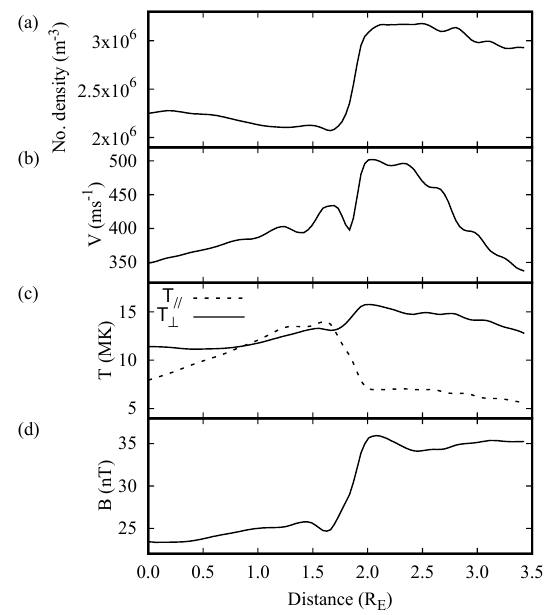
Figure 4. Cut across the bow wave front along the white arrow in Fig. 3 showing (a) the plasma density and (b) velocity, (c) the tem- perature parallel and perpendicular to the magnetic field, and (d) the magnetic field intensity. The correlated jump in all these parameters at the abscissa 2 R E characterizes the steep fast forward wave front. Note the fast wave signature in the perpendicular temperature while the parallel temperature is much more sensitive to the particle beam accelerated ahead of the wave